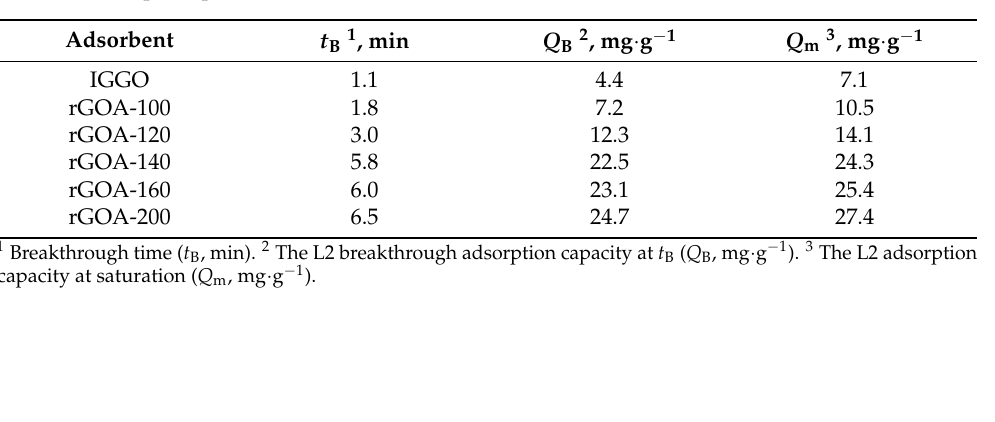
Table 2. Adsorption parameters of the adsorbents for